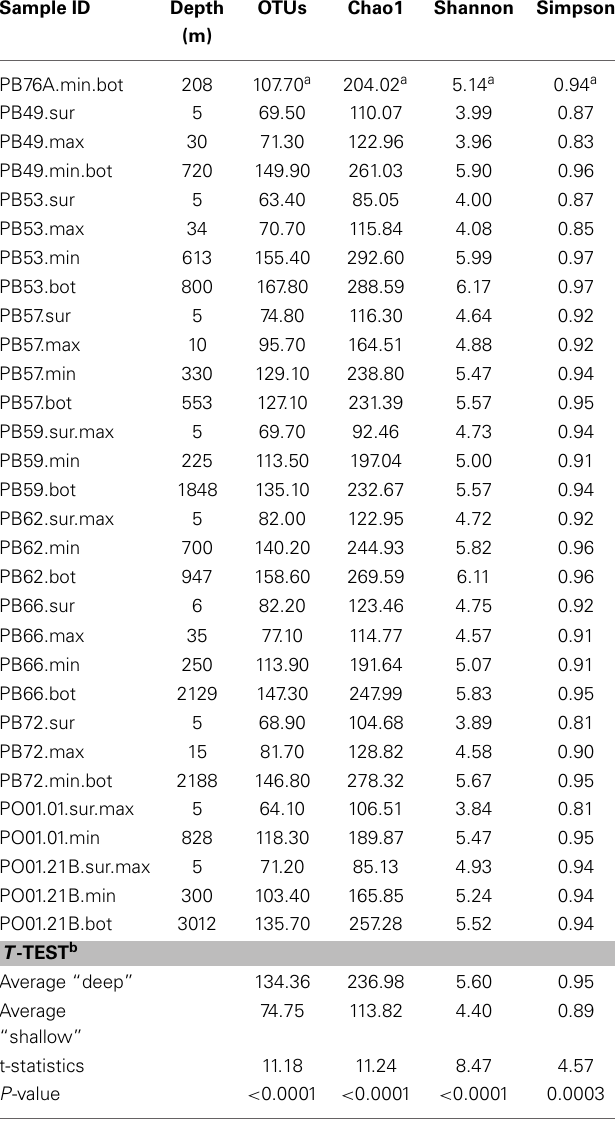
Sur, surface; max, maximum of dissolved oxygen; min, minimum of dissolved oxygen; bot, near the bottom. a All values are averages based on 10 rarefactions at 594 sequences per sample. b Results of Student t-test, testing the null hypothesis of equality of means in “deep” samples (oxygen minimum or near the bottom) vs. “shallow” samples (surface or oxygen